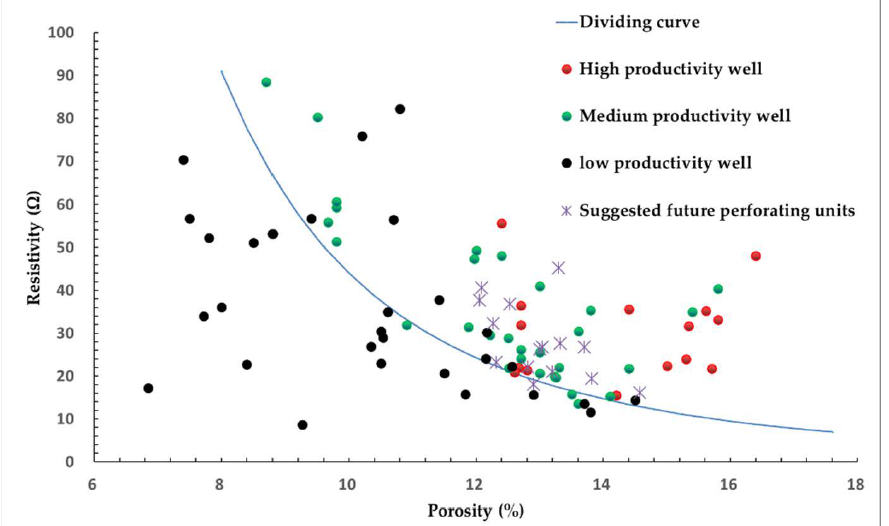
Figure 11. Gas well productivity corresponds to well logging interpreted porosity and resistivity.